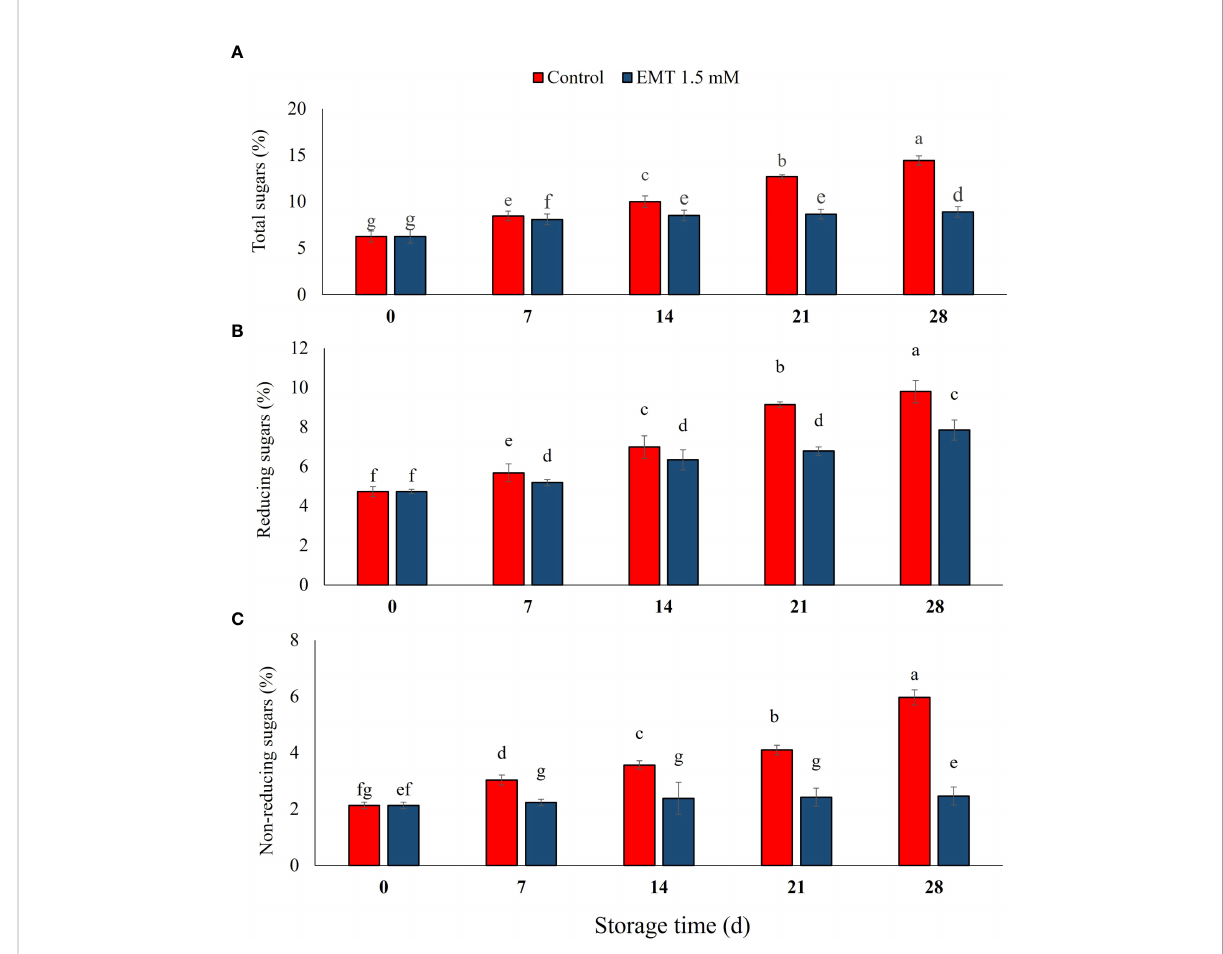
FIGURE 3 Effect of EMT treatment on total sugar (A) , reducing sugar (B) , and non-reducing sugar (C) of papaya fruits during cold storage. Data collected from the mean of three replicates, and vertical bars indicate the standard error of the means. Mean values with different letters show signi fi cant differences, and those with the same letters show no statistical difference according to the least signi fi cant difference test ( P <